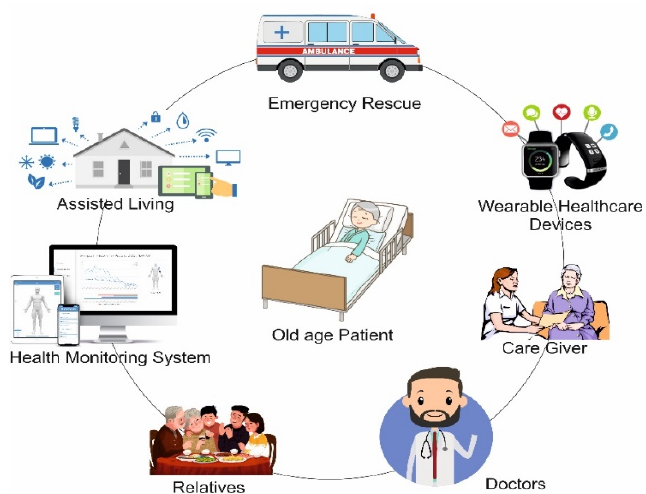
Figure 1. Graphical illustration of an AAL system environment.